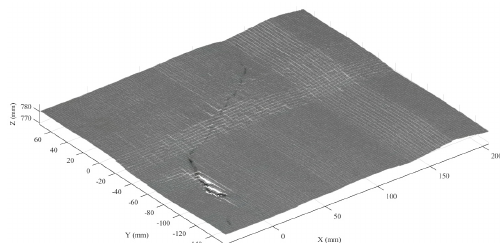
Figure 5. Registered 3D Point Cloud of Cracked Surface